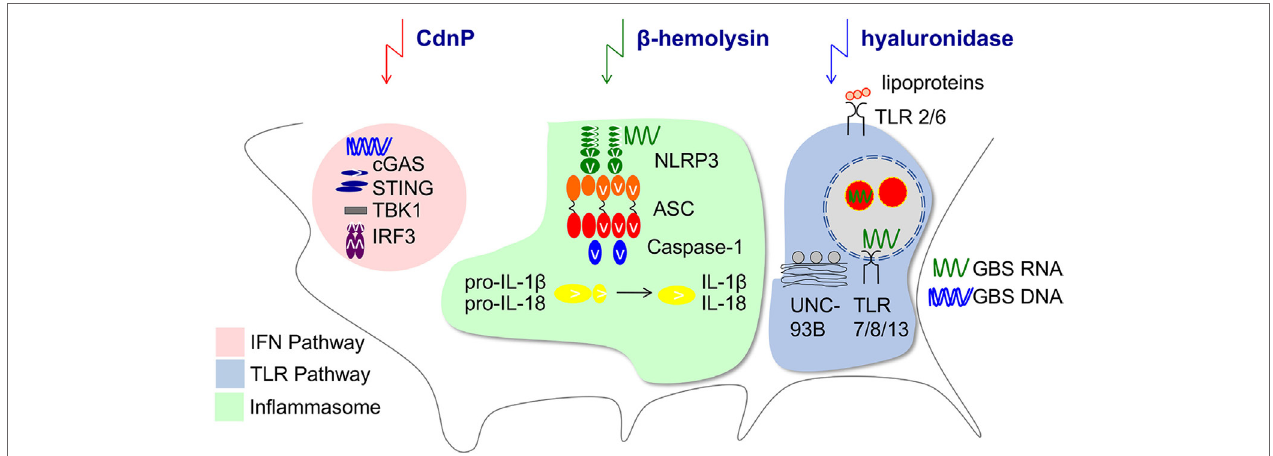
FiGURe 1 | Innate immune pathways manipulated by Group B Streptococcus . Depicted is the impact of GBS on type I interferons (IFN) (153, 155), Toll-like receptor (TLR) (10, 149), and inflammasome (151) pathways by secreted bacterial factors. The ectonucleotidase CdnP hydrolyzes bacterial cyclic dinucleotides which otherwise activate STING and IFN- β production (154). Hemolysin contributes as second signal to the NLRP3 inflammasome activation (152). The GBS hyaluronidase can degrade pro-inflammatory hyaluronan polymers during tissue injury which normally bind to TLR2 and the resulting fragments block TLR2 signaling in the host (157).